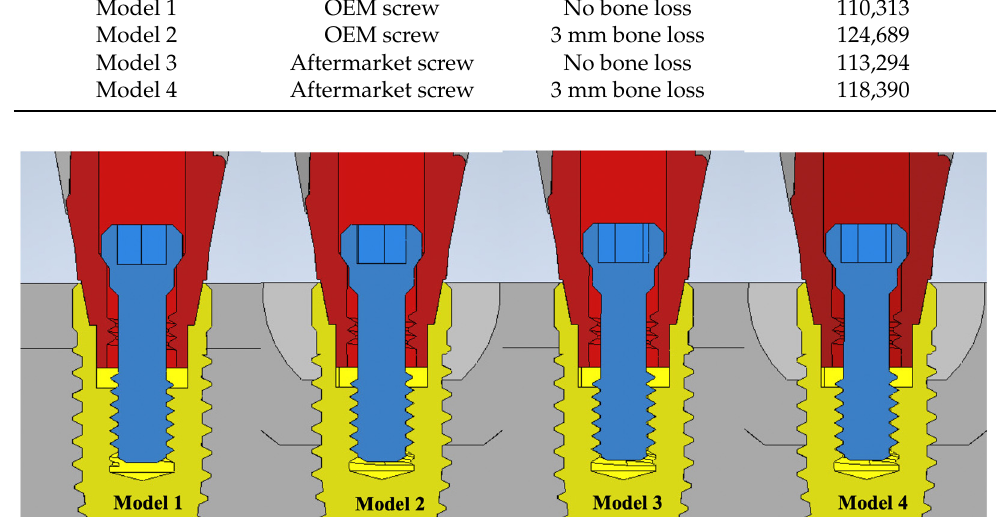
Figure 2. The cross-section of four CAD geometry models. Model 1—OEM screw with no bone loss; Model 2—OEM screw with 3 mm angular bone loss; Model 3—aftermarket CAD/CAM screw with no bone loss; Model 4—aftermarket CAD/CAM screw with 3 mm angular bone loss.